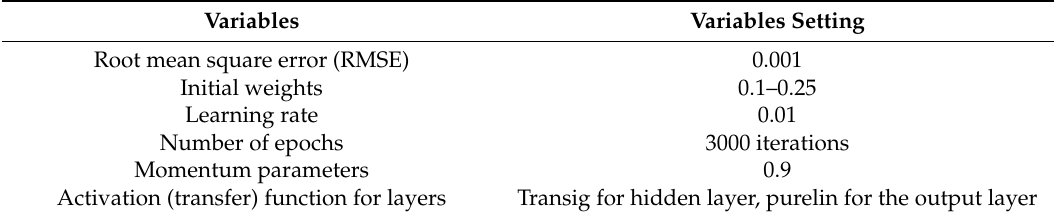
Momentum parameters 0.9 Transig for hidden layer, purelin for the output